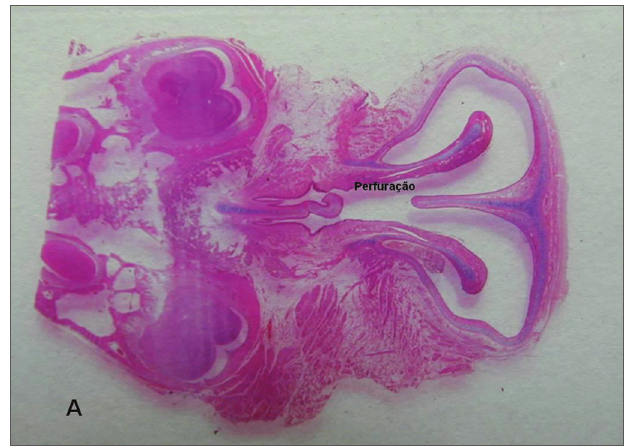
Figura 3. Fotomicrografia de lâminas histológicas de septo. A-septo roto (macro). Coloração HE.